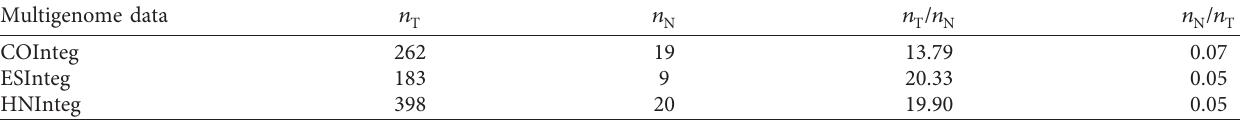
Table 4: The ratios of two types of samples on each multigenome data.